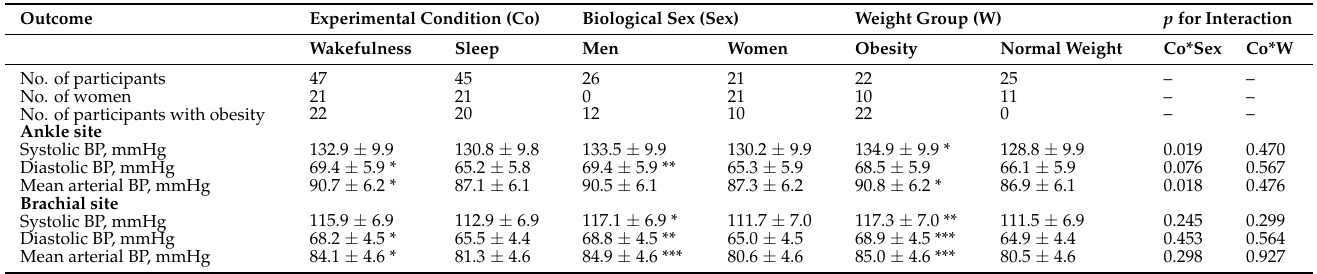
Table 1. Association of participants’ biological sex, weight group status, and experimental condition with morning resting blood pressure.